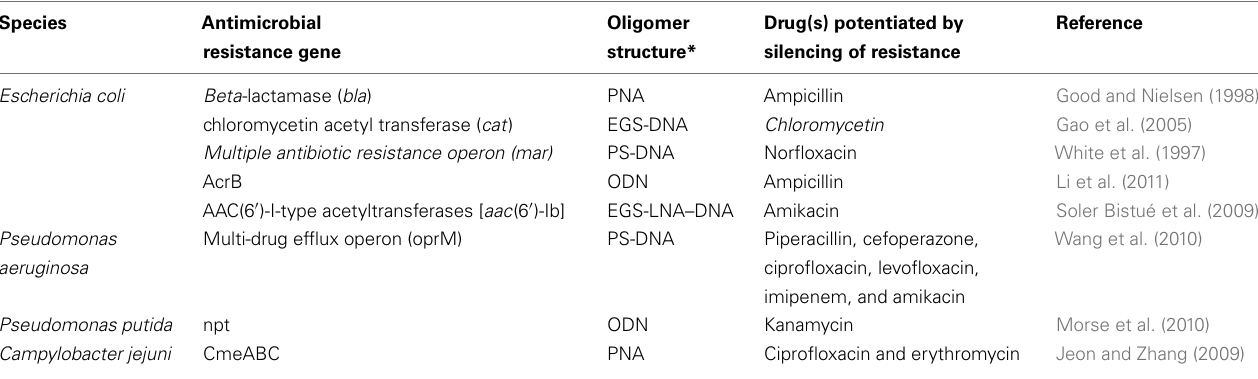
Table 1 | Examples of RNA silencing of antibiotic resistance mechanisms using oligomers.